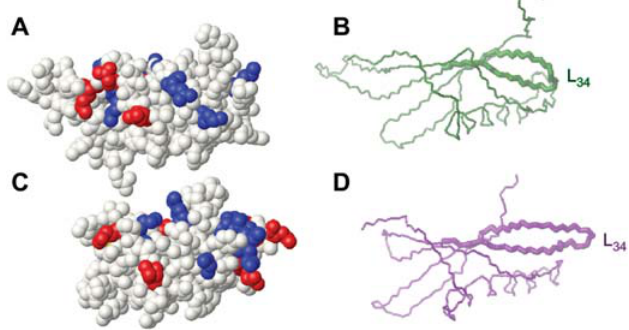
Figure 2 Comparison of the structures of MNEI and ORYZA. (A) All atom representation of the surface of interaction of MNEI with the sweet receptor, showing the distribution of basic (blue) and acidic (red) residues. (B) Neon representation of the backbone of MNEI; the L representation of the surface of interaction of ORYZA corresponding to that of MNEI (A), showing the distribution of basic (blue) and acidic (red) residues. (D) Neon representation of the backbone of ORYZA; the L generated by MOLMOL